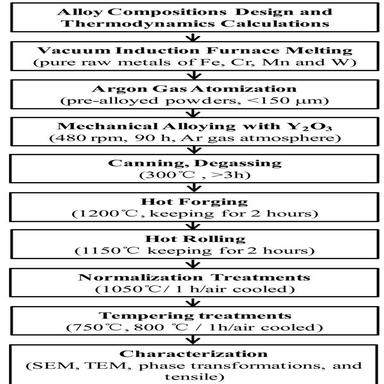
Manufacturing processes of the novel carbide-free 9Cr-ODS martensite steel.